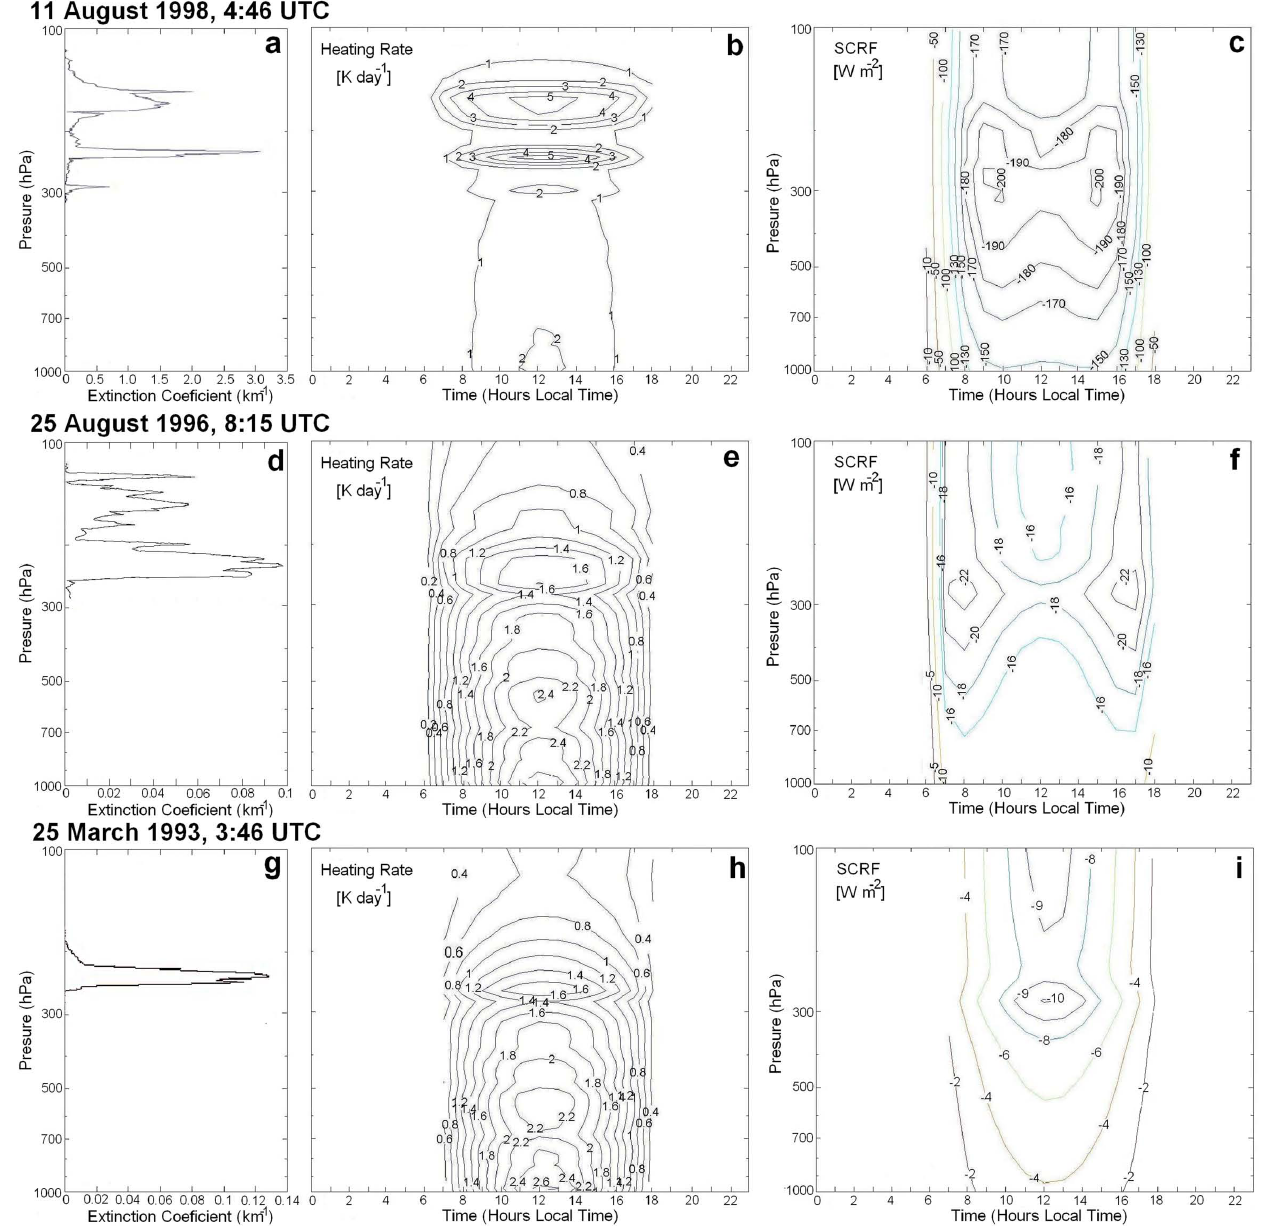
Fig. 1. Examples of cirrus clouds cases: extinction coefficient profiles, diurnal cycle of heating rate and SCRF. Top panel: Opaque cirrus cloud; medium panel: Thin cirrus cloud; bottom panel: Subvisible cirrus